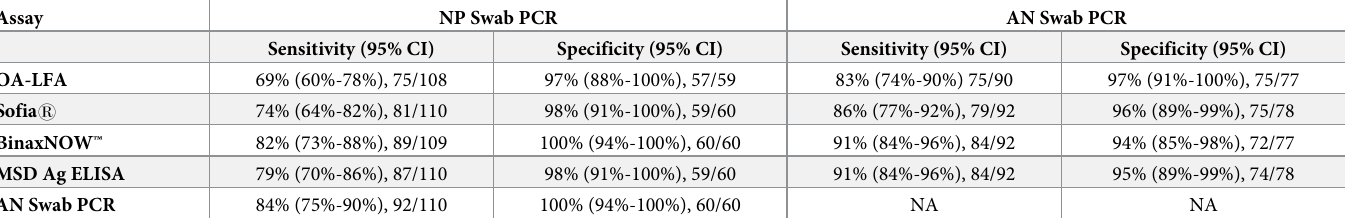
Table 1. Positive percent agreement and negative percent agreement values, including 95% confidence intervals, for all assays with either nasopharyngeal (NP) and anterior nares (AN) PCR as reference. Assay